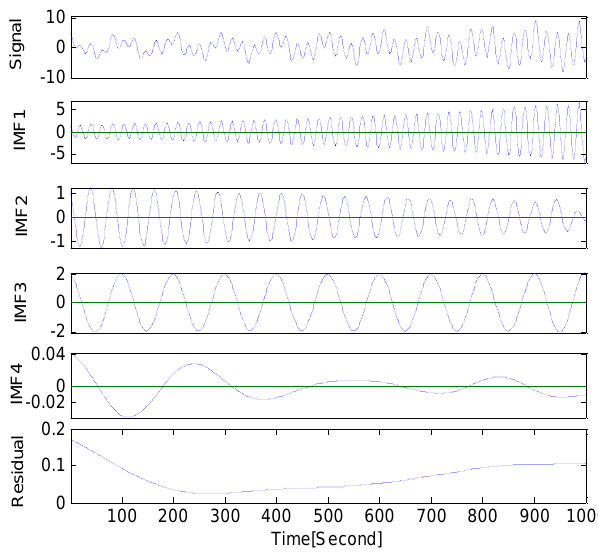
Fig. 1. Signal f (t) = 1 . 5 × e ξ 2 πf 1 t cos ( 2 πf 1 t) + 1 . 5 × e − ξ 2 πf 2 t cos ( 2 πf 2 t) + 2 × cos ( 2 πf 3 t) + G(t) and its decom- positions using the EMD method. ( f 1 = 1 / 21, f 2 = 1 / 41, f 3 = 1 / 100Hz, ξ = 0 . 01 and the standard deviation of the mean-zero white noise is 10% of the signal strength).